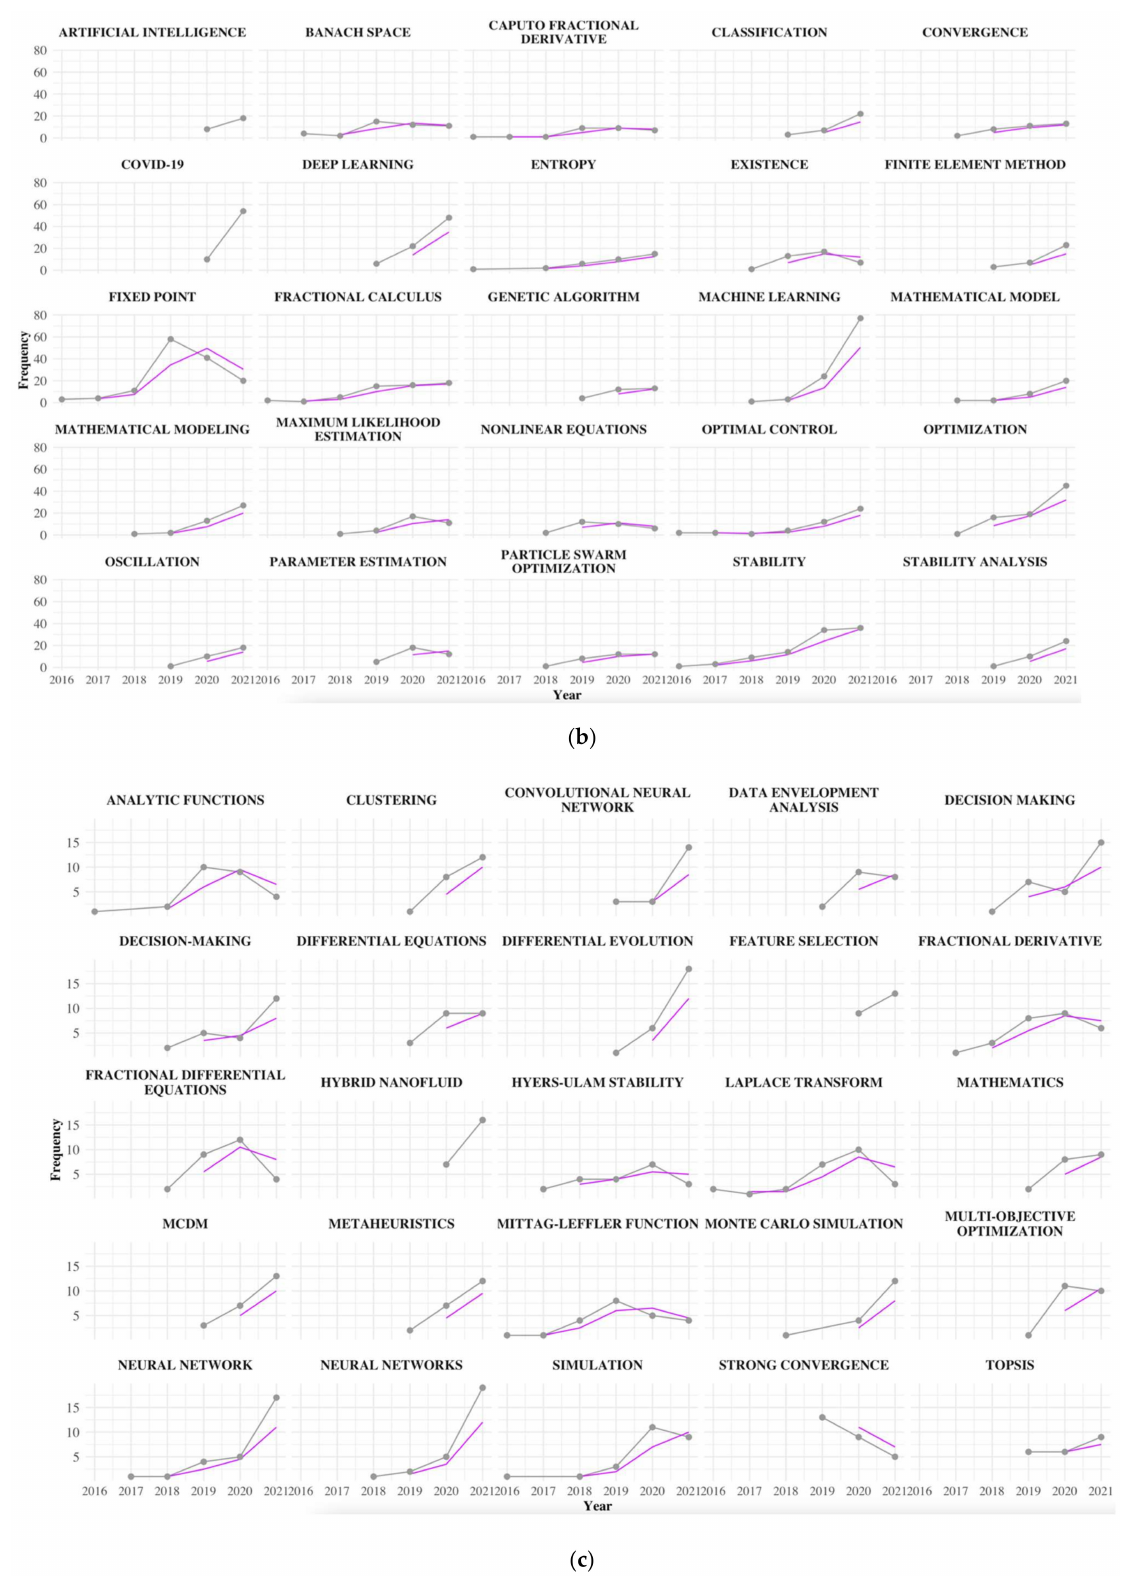
Figure 2. ( a ): Frequency analysis of author-entered keywords. ( b ): Longitudinal analysis of